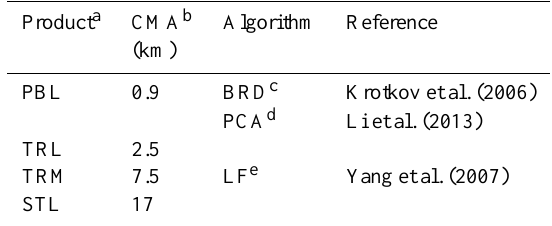
Table 1. Summary of the SO 2 retrieval